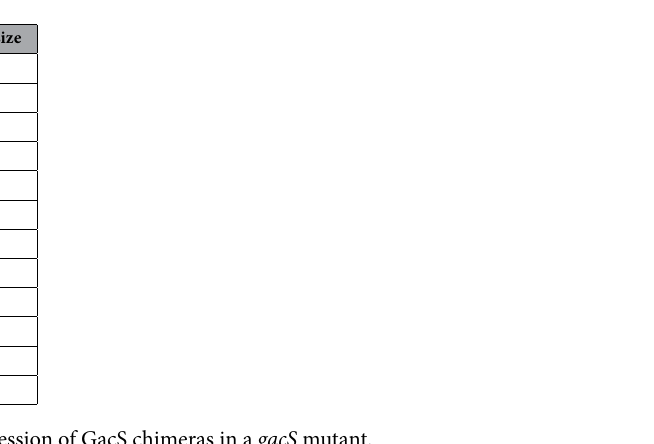
Table 2. Phenotypes obtained by expression of GacS chimeras in a gacS mutant.